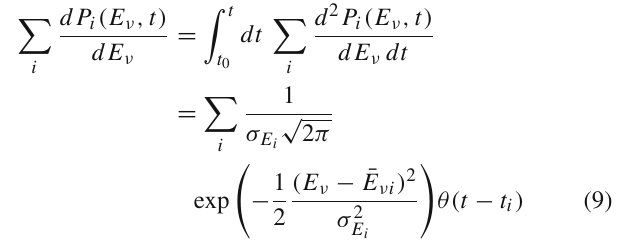
Fig. 3 Theoretical events rate cumulative integrated over time (Eq. 8) (blue) and normally distributed data as proposed in (9) (red) changing along relative detection time since the first measured neu- trino from SN1987A. The time scale runs logarithmically in the first second and linearly afterwards to better show the data struc- ture for early time events (see the animation here: https://github. com/santosmv/Animations-visualizing-SN1987A-data-analysis/blob/